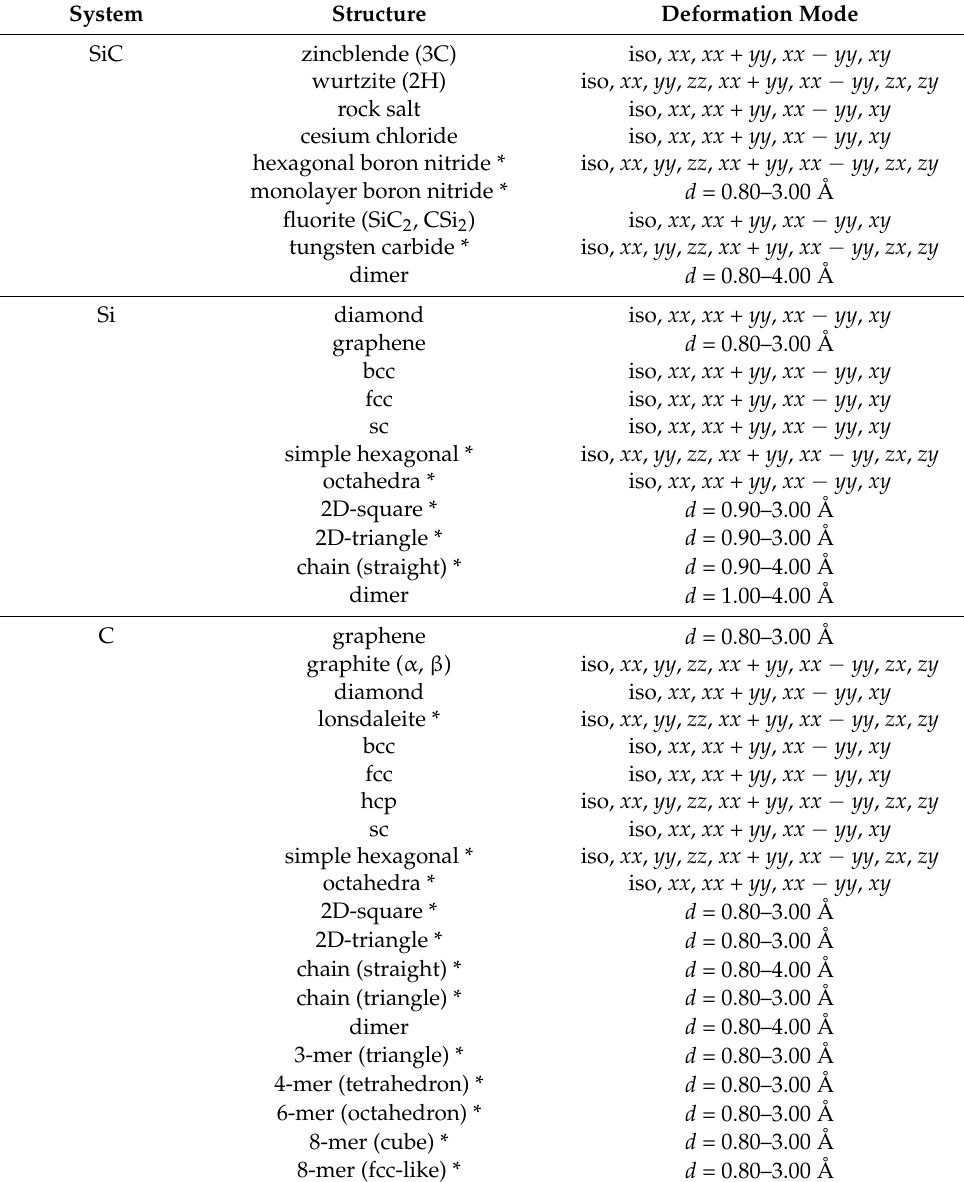
Table A1. Typical crystal structures and deformation modes considered as reference data. The struc- tures with an asterisk (“*”) are visualized in Figure